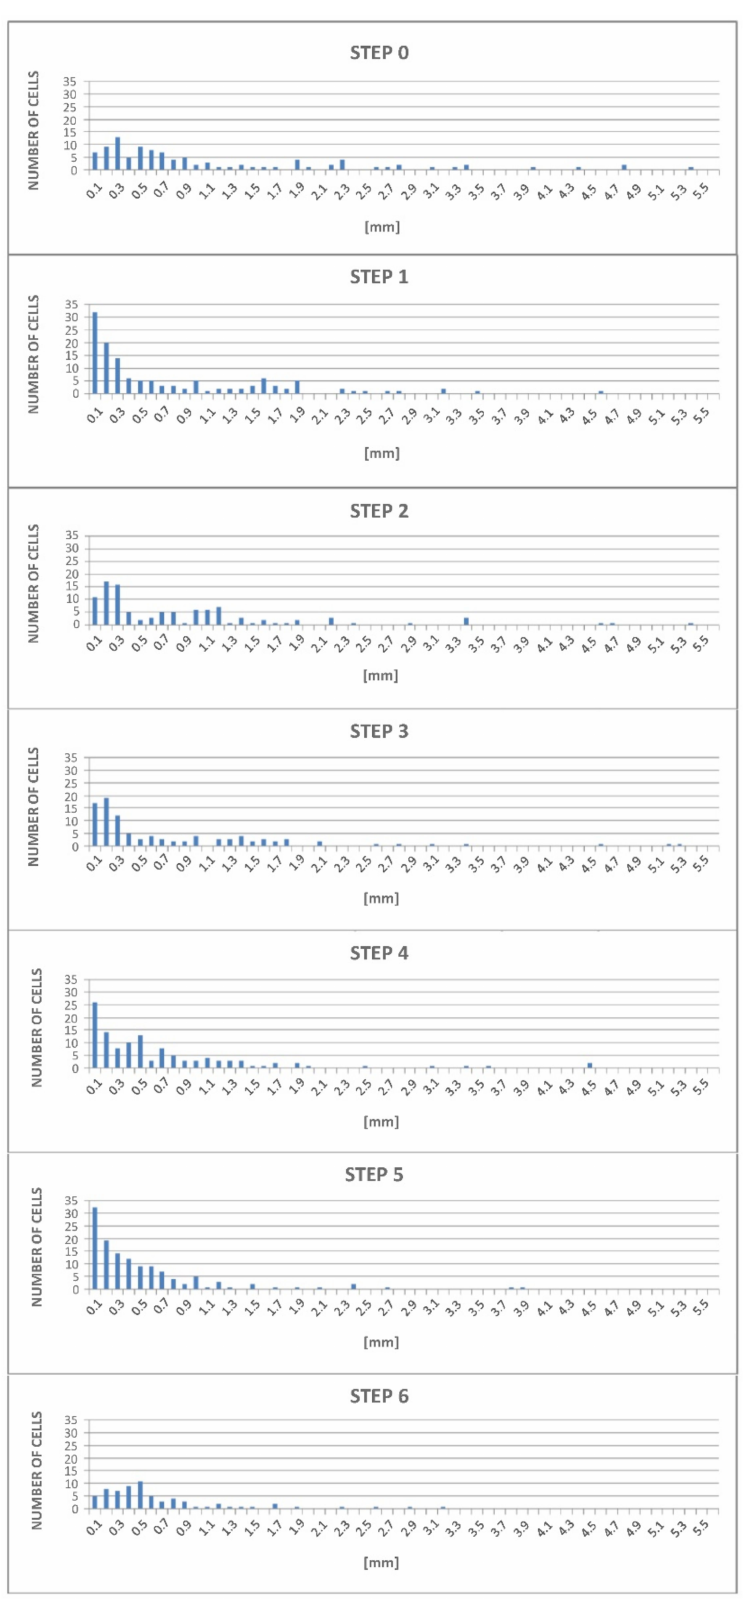
Figure 8. Distributions of the equivalent diameter d eq at the end of each compression step (0.4% TiH 2 foam, XZ